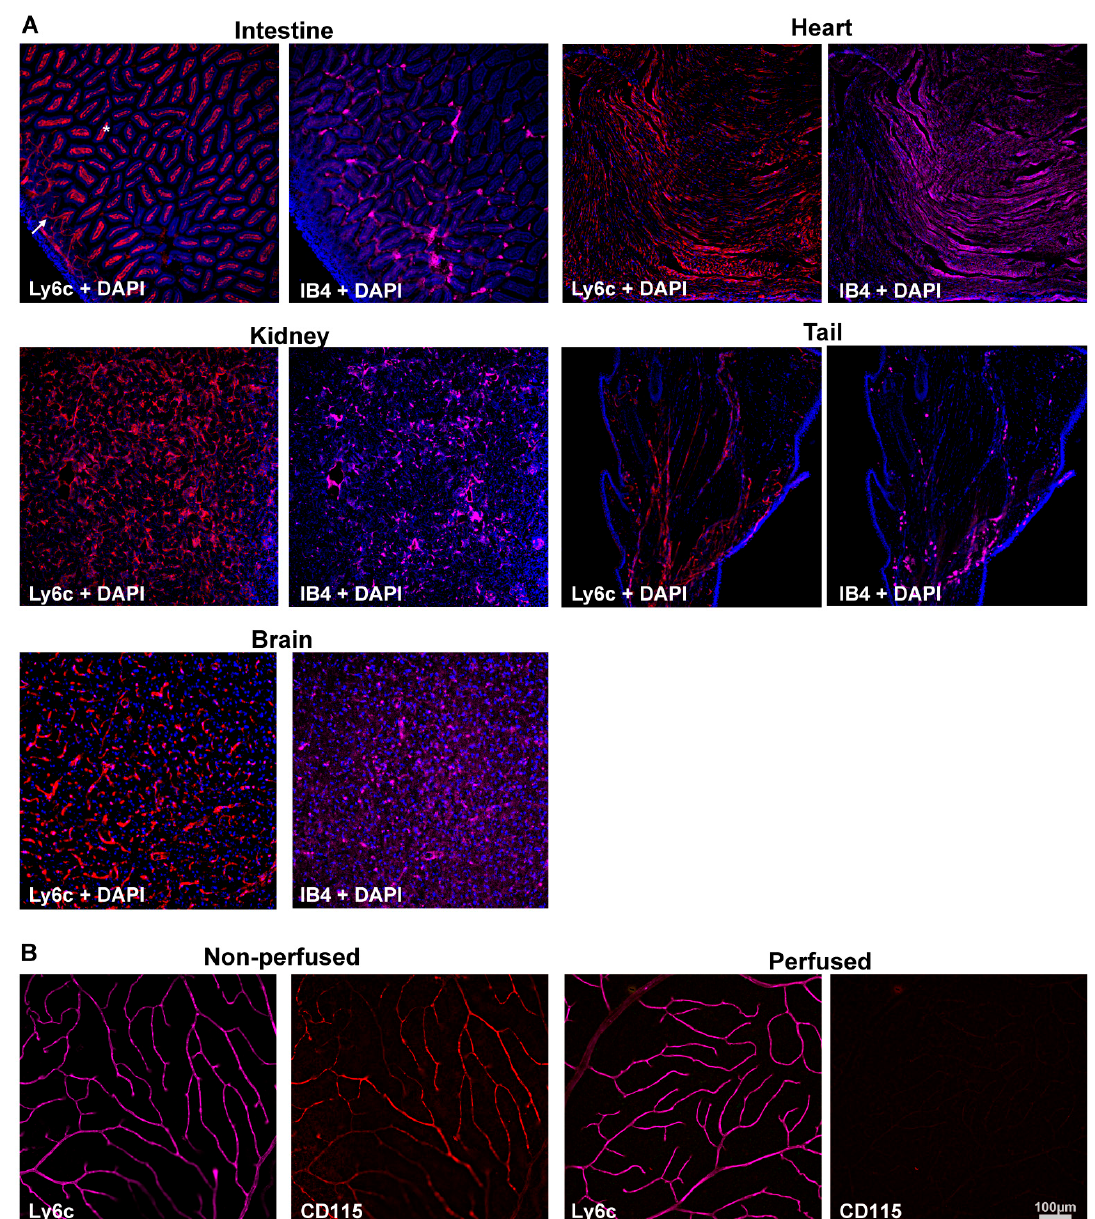
Figure 1. Ly6c is expressed in mouse blood vessels. ( A ) Ly6c (red) and IB4 (purple) detection in several tissues showing Ly6c signal in the brain, intestine, kidney, heart, and tail. The arrow points to blood vessels, and the asterisk to macrophages in the intestinal villi. Nuclei are counterstained with DAPI (blue). ( B ) Ly6c (purple) and CD115 (red) double immunodetection in non-perfused and perfused retinas. Scale bar is the same for all panels.